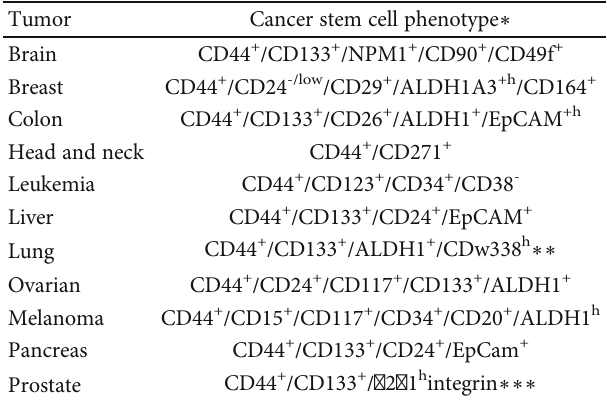
Table 1: Tumors and their cancer stem cell mark.